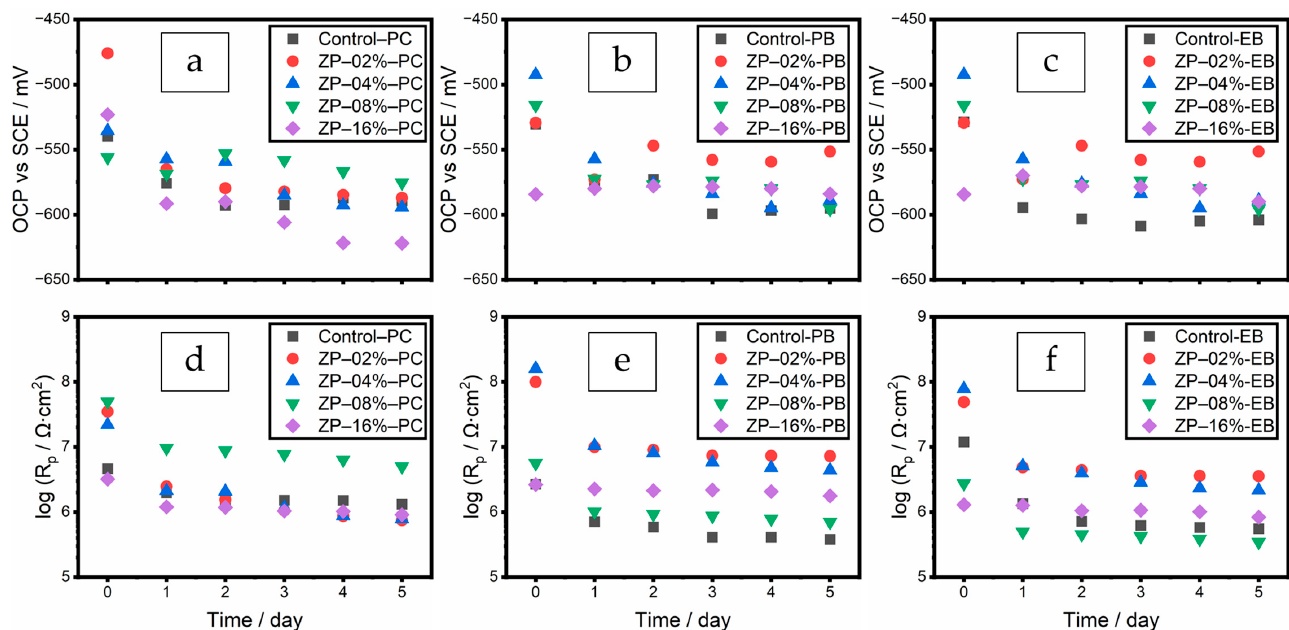
Figure 3. OCP and R p values of ZP in PC ( a , d ), PB ( b , e ), and EB ( c , f ). Compared with the polyester/TGIC clearcoat (Control-PC), the polyester/TGIC with filler BaSO 4 (Control-PB) had slightly higher OCP values and R p values at the same order of magnitude. These values indicated that the filler alone did not improve the barrier ef- fect. The additional defects in the coating film negated the benefit of increased tortuosity introduced by the